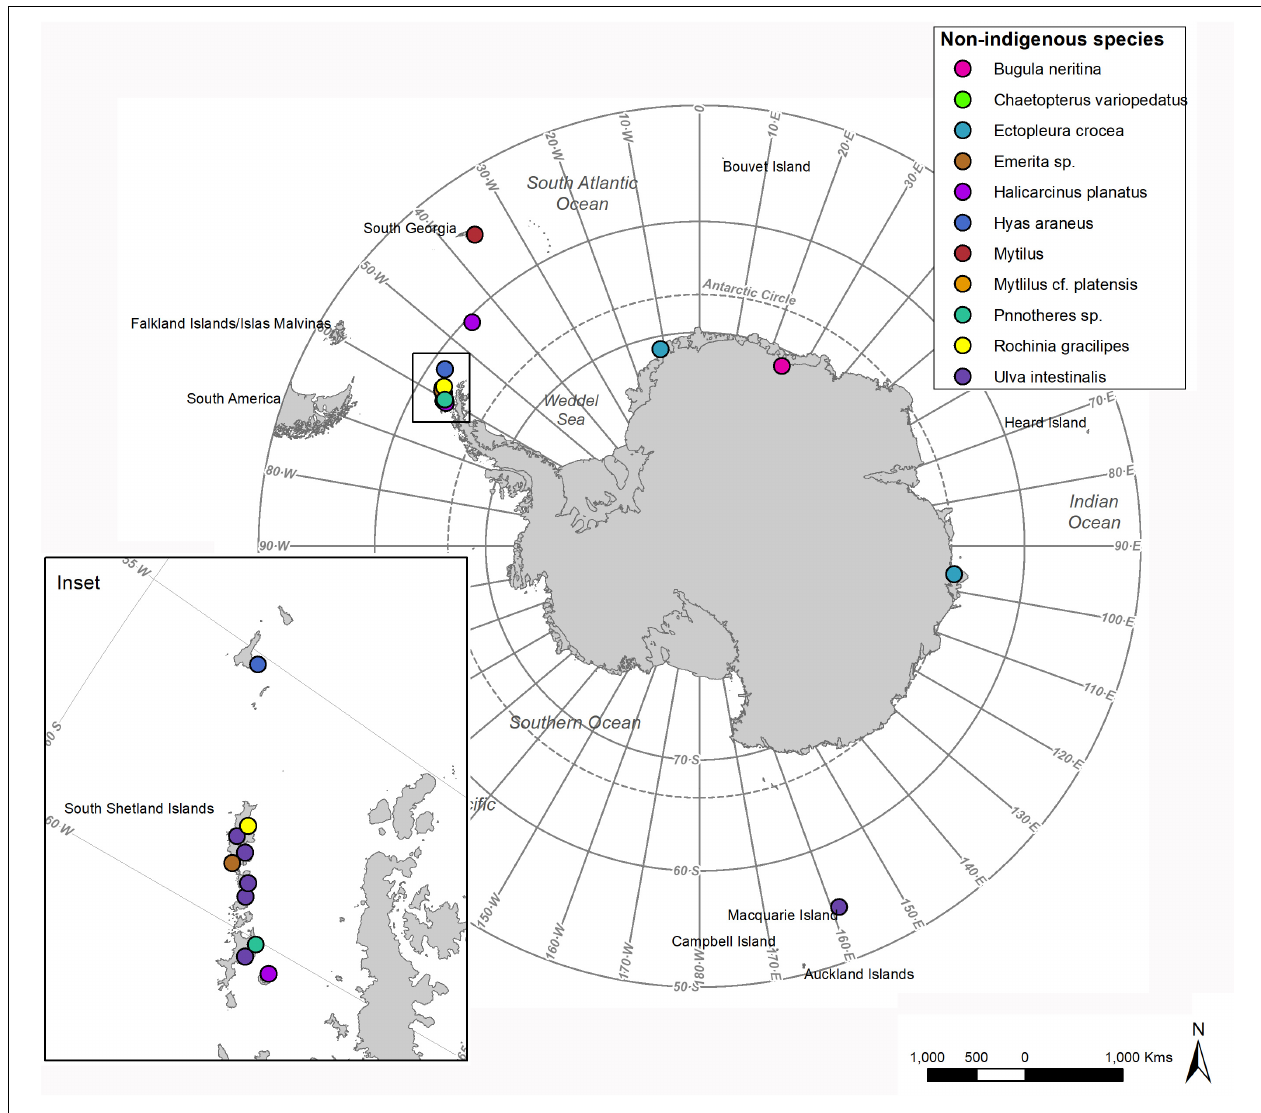
FIGURE 3 | Locations of records of non-indigenous species within the MEASO region. References cited in text and McCarthy et al. (2019). Map produced using data from the SCAR Antarctic Digital